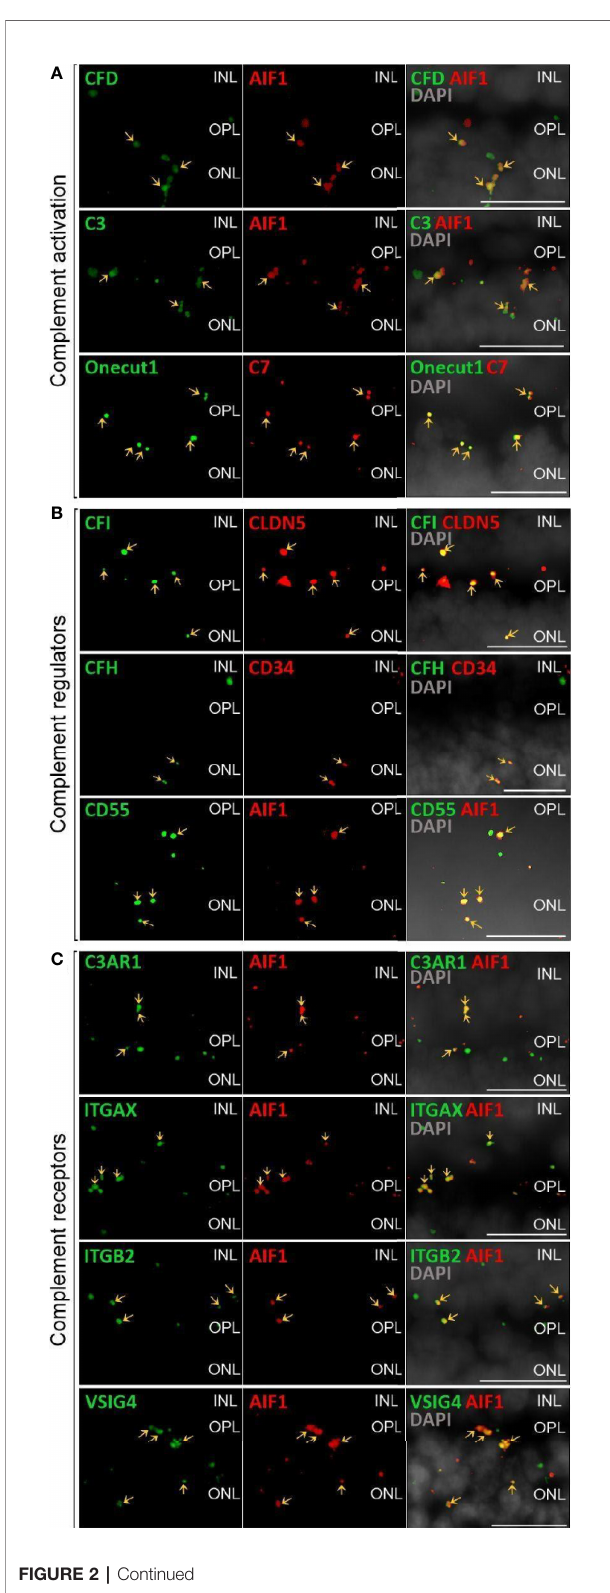
FIGURE 2 | Validation of scRNA-seq for retinal complement component expression by in situ hybridization. (A) Factors driving complement activation were chosen for detection by in situ hybridization. CFD expression from microglia was detected in the inner nuclear layer (INL), outer plexiform layer (OPL) and outer nuclear layer (ONL), but was mostly associated with microglia expressing AIF1 (alias IBA1 ) in the OPL. C3 expression was mostly limited to microglia located in OPL. C7 transcripts were detected in the OPL with overlap of signal with the horizontal marker Onecut1 in the OPL. (B) Soluble ( CFH, CFI ) and membrane-bound ( CD55 ) complement regulators primarily colocalized with vascular cells and microglia. Signals of CFH transcript were strongest from INL and OPL and overlapped with the endothelial marker CD34 . CFI expression associated with the endothelial marker CLDN5 was strongest in the INL and OPL. CD55 was robustly expressed in microglia expressing AIF . (C) Complement receptor C3AR1 transcripts were detected at low levels in the INL and OPL and co-localized with the microglia marker AIF1 . ITGAX was robustly expressed in the OPL and co-localized with the microglia marker AIF1 in the OPL. ITGB2 transcripts were less abundantand co-localized with AIF1 in the OPL. Also VSIG4 was strongly expressed in OPL and ONL co-localizing with the microglia marker AIF1 . (A – C) Arrows indicate co-localization of the gene of interest with respective cell marker. Scale bars,